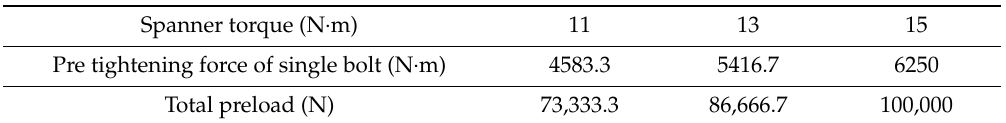
Figure 21. Equivalent friction coefficient. Under different axial pressures, the equivalent friction coefficient is not the same, which is due to the error in the process of readjustment and installation after each group of experiments. The equivalent friction coefficient obtained from the three sets of data is greater than the friction coefficient of the clamp directly contacting with the steel pipe. The correctness of the surface experiment scheme further explains the safety of the grouting mechanical clamp. The equivalent friction coefficient obtained in the figure above is 0.43, which is a certain difference from the predicted value. According to the above experiments, the friction coefficient of the wedge tooth under direct loading is greater than the equivalent friction coefficient of the mechanical grouting clamp. This is because the way of applying force to the wedge on the clamp provides the pressure for the clamp outer sleeve. Compared with the way of applying axial force to the wedge tooth directly, the way of applying force is different, resulting in the different friction coefficient. 4. Conclusion In this paper, the Morison formula is mainly used to analyze the linear wave load of grouting clamp. In this paper, the hydrodynamic analysis of grouting in different installation positions is carried out innovatively, and the test method of grouting clamp is put forward. The feasibility of grouting hoop reinforcement method in the repair of local damage of offshore jacket is verified. The Morison formula is used to analyze the clamps at different installation positions, and the wave force on the clamps is obtained. It is further known that the wave force of the vertical grouting clamp is mainly related to the wave velocity in the horizontal direction, and the vertical grouting clamp will also accept upward lifting. When the clamp is installed horizontally and the wave current